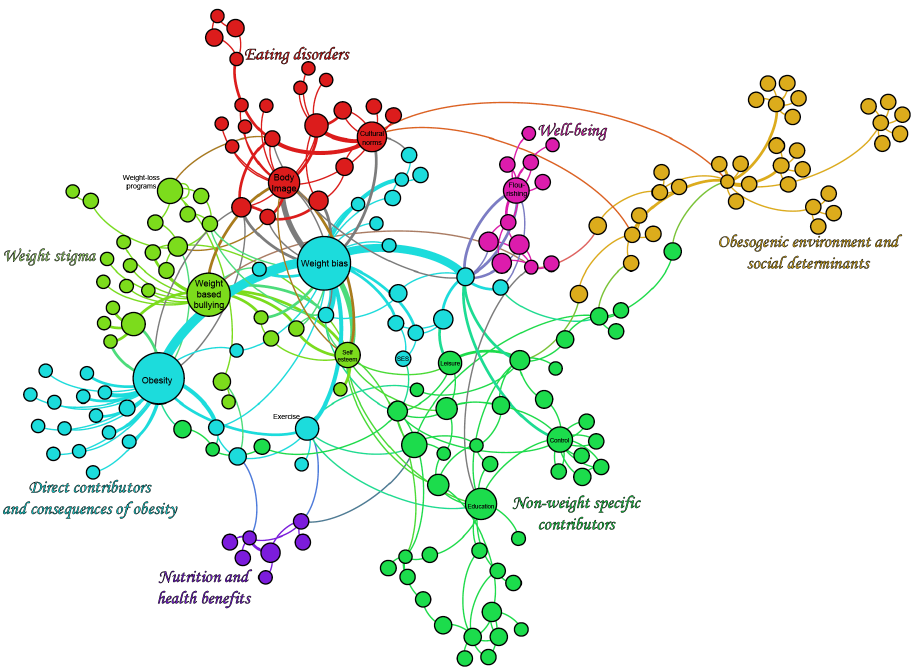
Figure 3. Visualization of the PHSA report [56] as a causal map, where each factor is shown as a node (circle). This map was extended into a version with 98 factors [20]. Sizes indicate centrality and colors indicate themes, which are automatically inferred from the network structure by community extraction algorithms. Through this high-level map, it is possible to see how the overall system is composed of interacting themes such as weight stigma (closely related to eating disorders), well- being, or nutrition and health benefits.